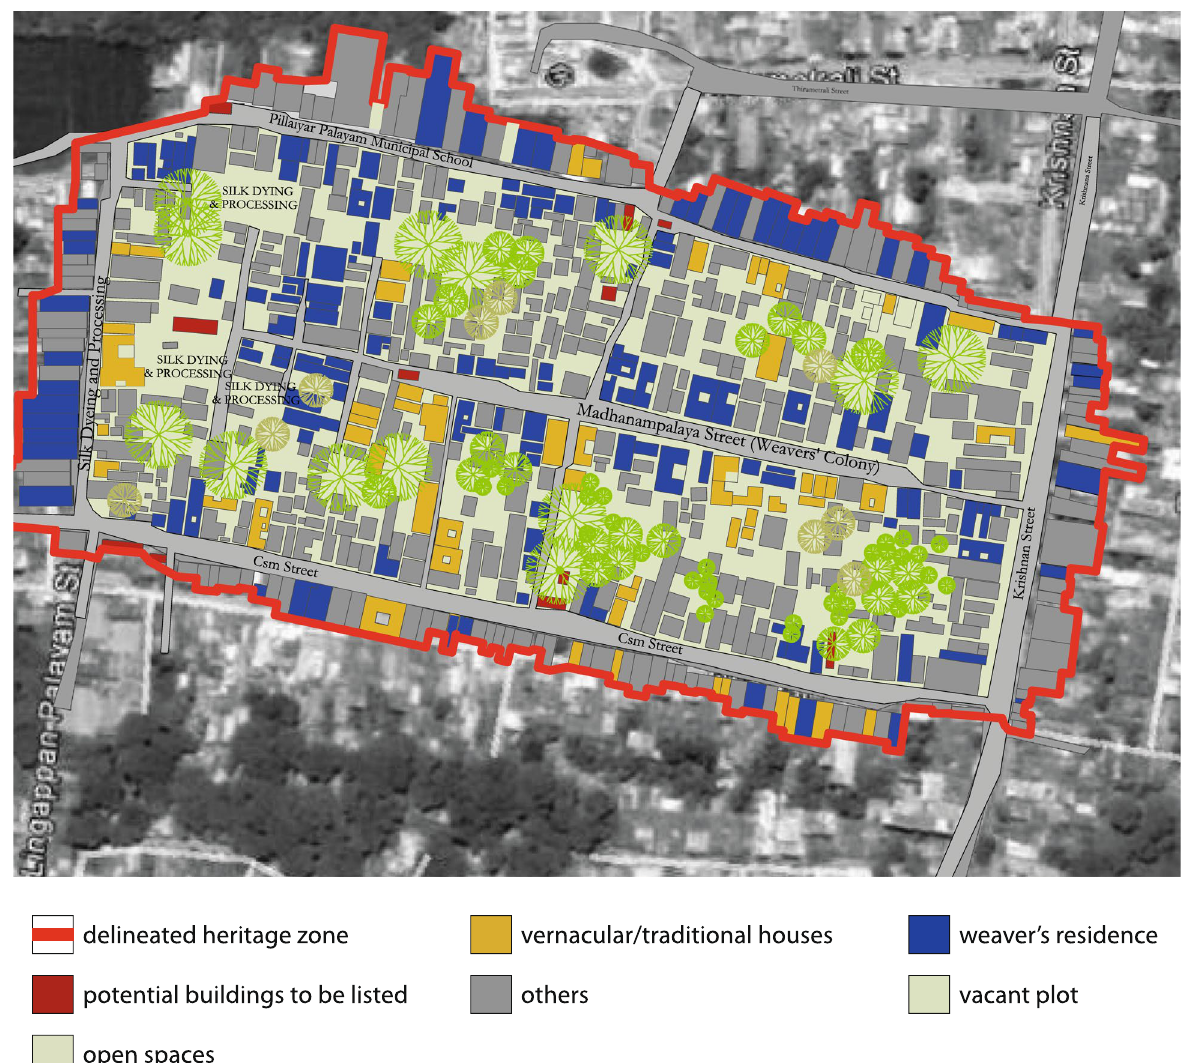
Fig. 3 Map showing the land use within the Pillayarpalayam heritage zone (Source: Abha Narain Lambah Associates